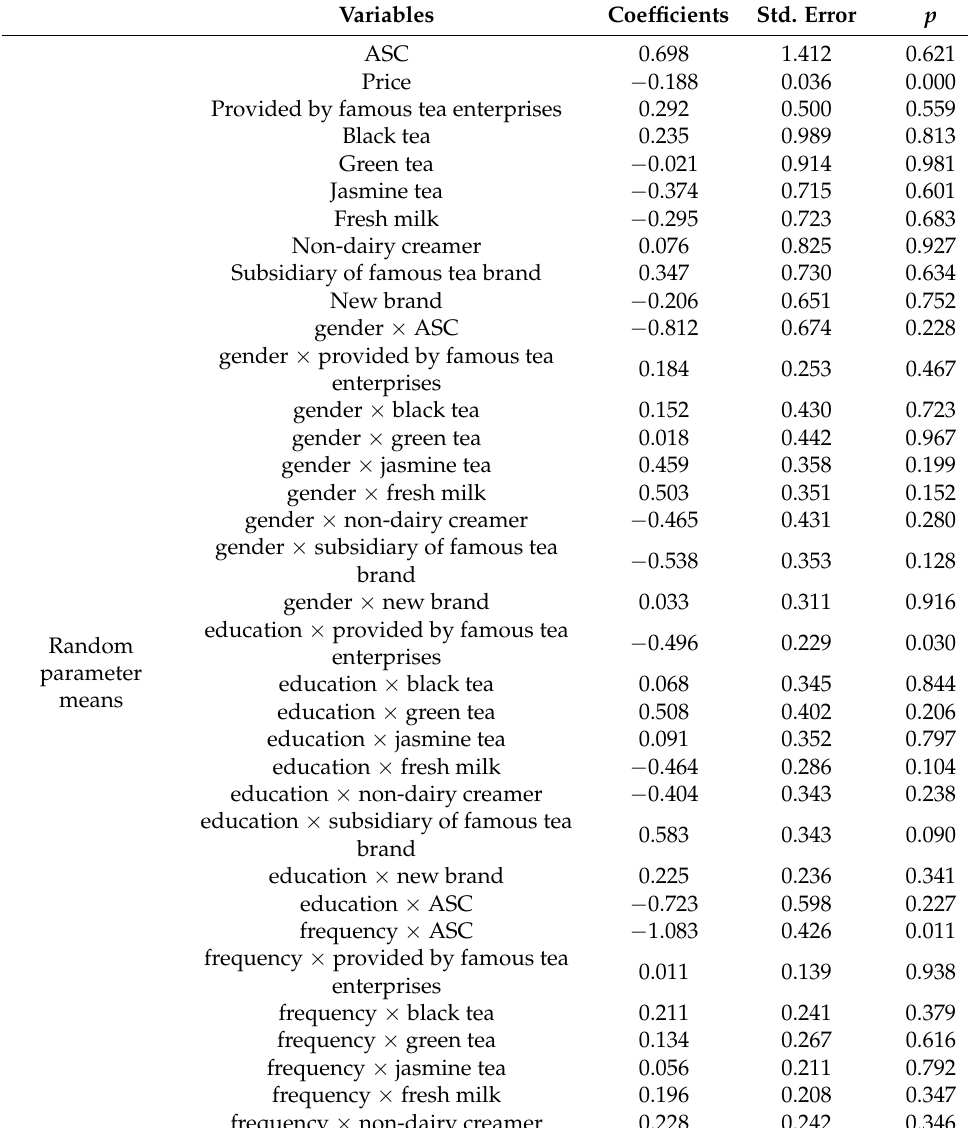
Table 4. Estimation of the interaction effects of attributes with socio-demographic variables using RPL